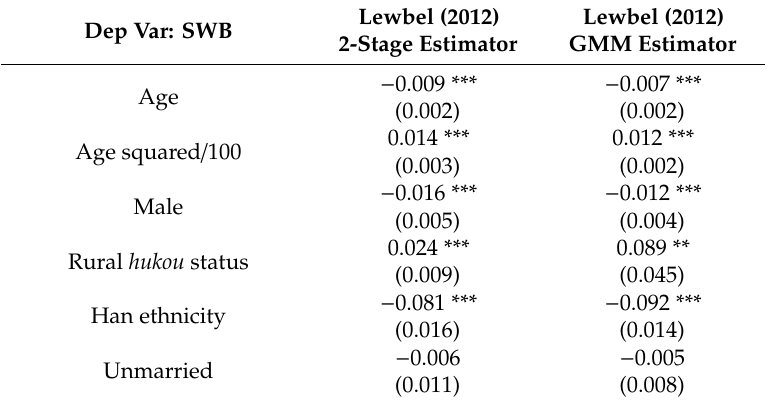
Table A4. The results of the omitted controls in Table